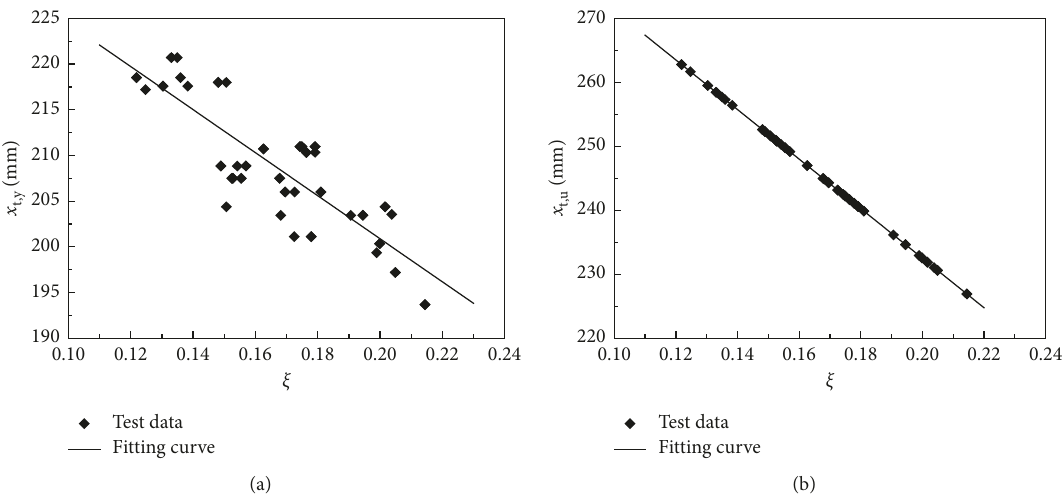
Figure 15: Relationship between ξ and x t at (a) yielding and (b) nominal ultimate states.